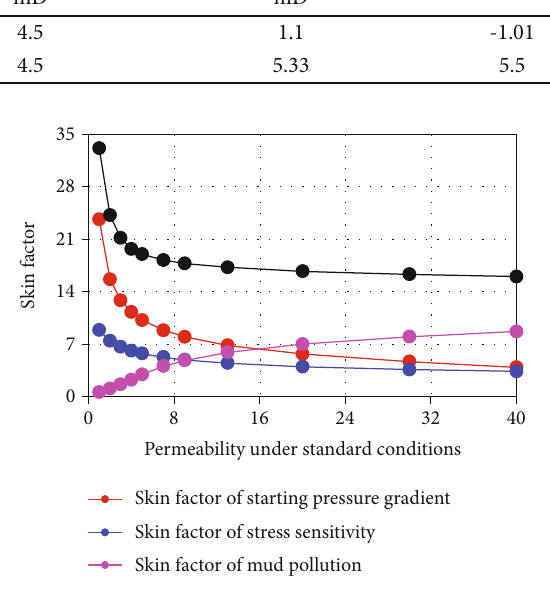
Table 6: Comparison table for result interpretation of di ff erent wells in the XJX-2Sa well. Case